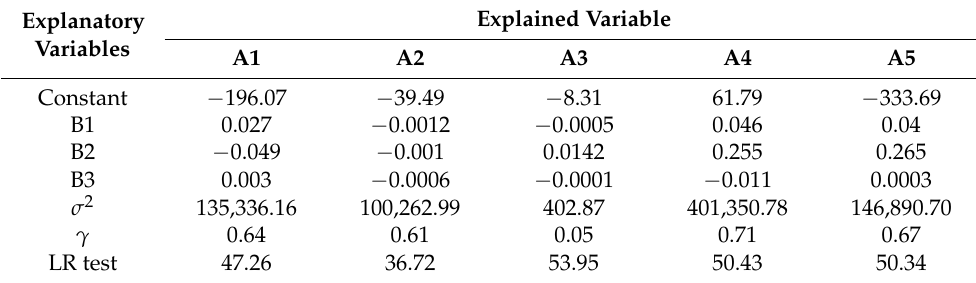
Table 4. SFA regression results.